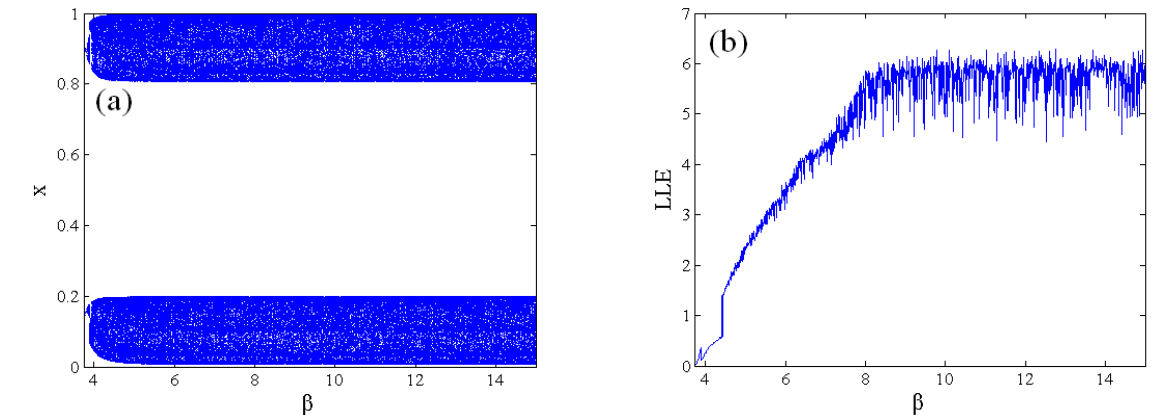
Figure 3. Bifurcation portrait and Lyapunov exponent spectrum with regard to β . ( a ) Bifurcation portrait with regard to β ; ( b ) Lyapunov exponent spectrum with regard to β .